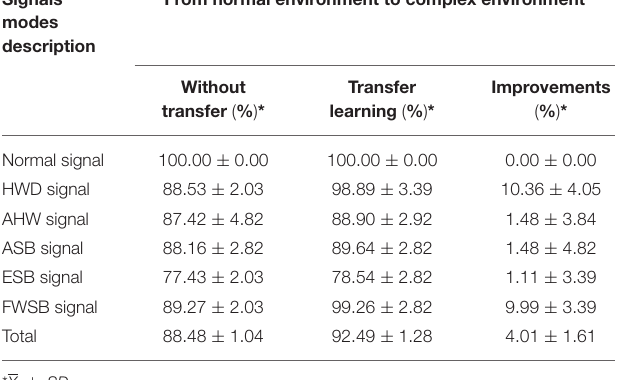
TABLE 3 | Fault diagnosis accuracy of the different methods. Signals modes